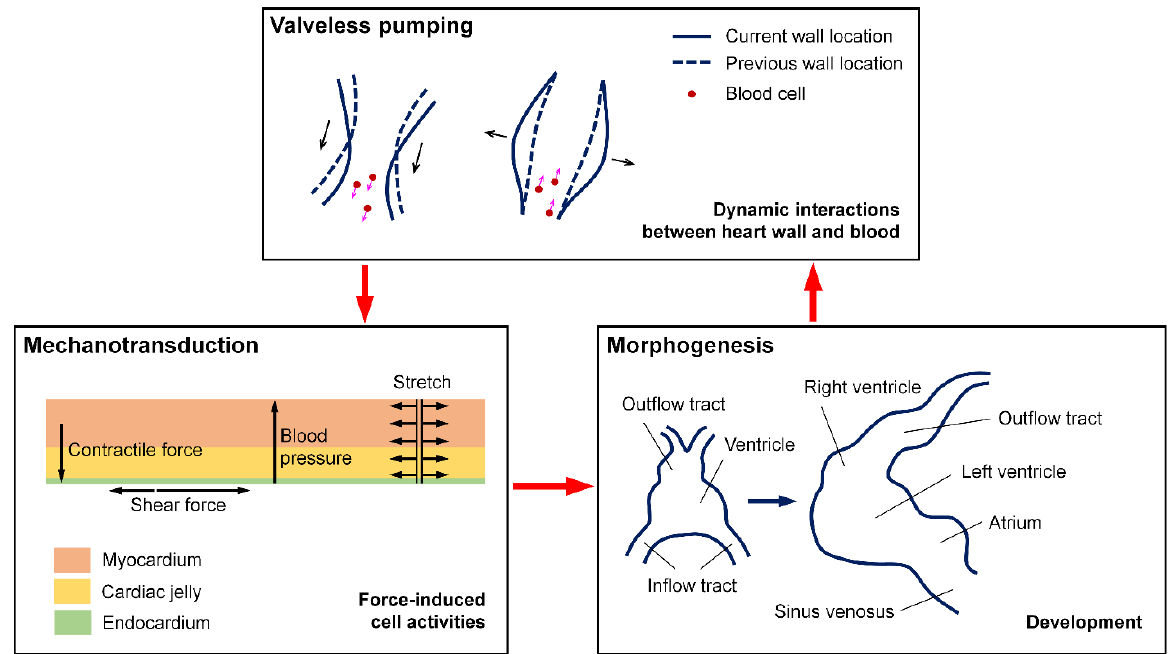
Figure 1. An illustration of the interplay between the cardiac pumping function and cardiovascular morphogenesis with mechanotransduction during early development.